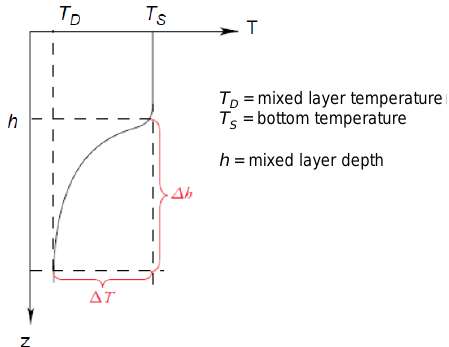
Figure 5 Schematic representation of the temperature profile in the upper mixed layer Figure 5. Schematic representation of the temperature profile in the and in the thermocline, reproduced from Killirin (2003). The self-similarity representation of upper mixed layer and in the thermocline, reproduced from Kil- the temperature profile in FLake is determined using dimensionless co- ordinates, ζ = ( z- h )/Δ h , and υ = [ T(z)-T D ]/Δ T. lirin (2003). The self-similarity representation of the temperature profile in FLake is determined using dimensionless co-ordinates, ζ = (z − h)/(cid:49)h and υ = [ T (z) − T D ] /(cid:49)T